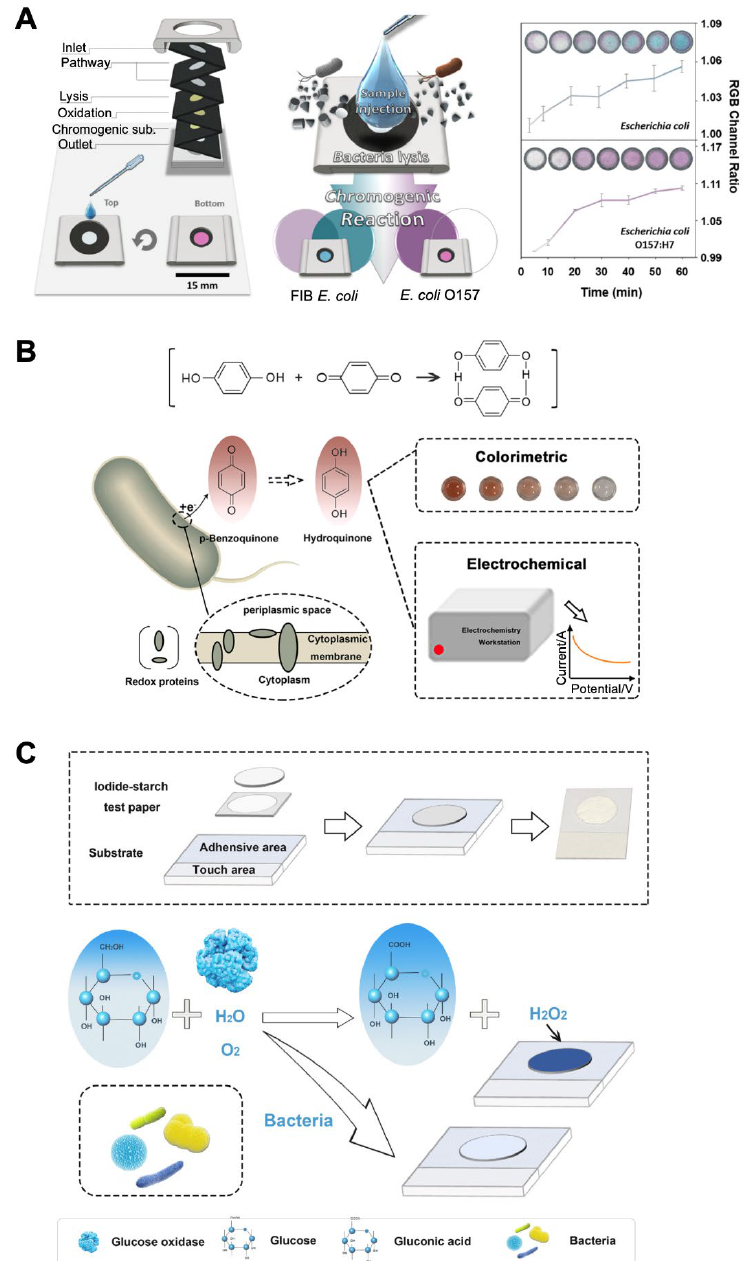
Figure 2. Colorimetric sensing strategy based on intracellular enzyme-catalyzed chromogenic reac- tions. ( A ) Discrimination of Escherichia coli and E. coli O157:H7 based on different cellular metabolic reactions ( β -glucuronidase- and β -galactosidase-based enzymatic reactions, respectively). Reprinted with permission from [32]. Copyright 2019, American Chemical Society. ( B ) Detection of E. coli and Staphylococcus aureus based on the reduction reaction of p -benzoquinone by intracellular enzymes. Reprinted with permission from [34]. Copyright 2019, American Chemical Society. ( C ) Detection of E. coli , S. aureus , Enterococcus faecalis , Streptococcus mutans , and Salmonella pullorum based on the conversion from iodide to iodine on the starch–iodide doping paper. This conversion is catalyzed by H 2 O 2 produced from glucose oxidase-mediated oxidation and glucose uptake of bacterial cells. Reprinted with permission from [35]. Copyright 2019, Elsevier. WST-8, 2-(2-methoxy-4-nitrophenyl)- 3-(4-nitrophenyl)-5-(2,4-disulfophenyl)-2H-tetrazolium, monosodium salt; RGB, red-green-blue; FIB, fecal indicator